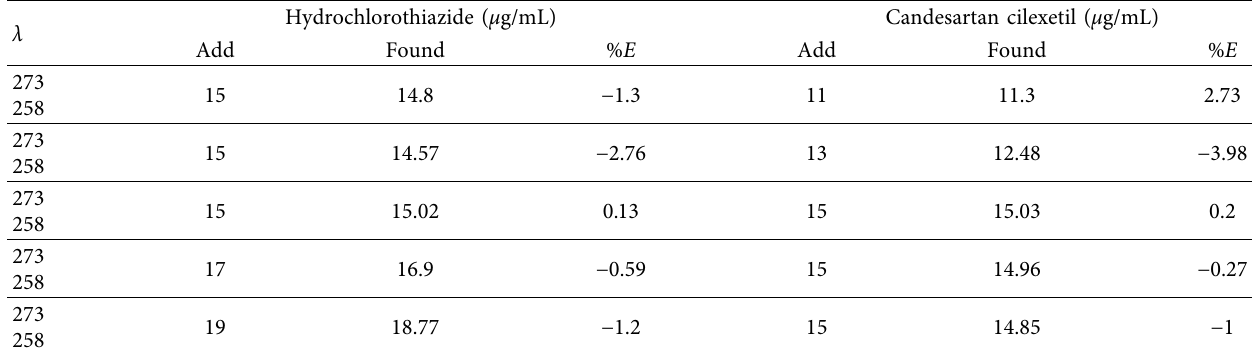
Table 8: Accuracy of the Q -absorption ratio method in the determination of HCT and CAN.